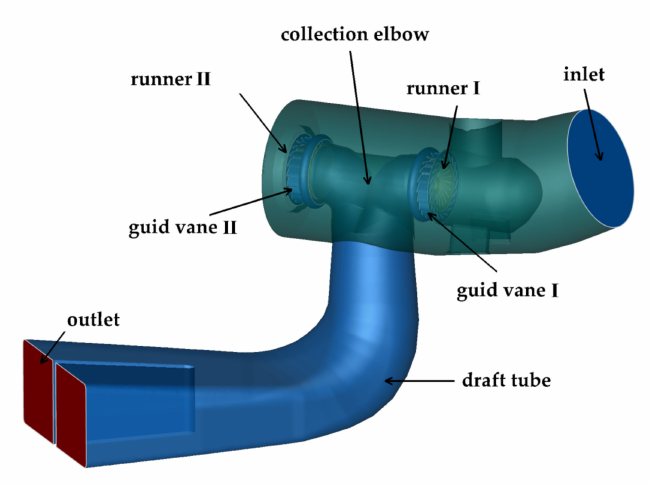
Figure 1. Full flow channel model of a double-runner Francis